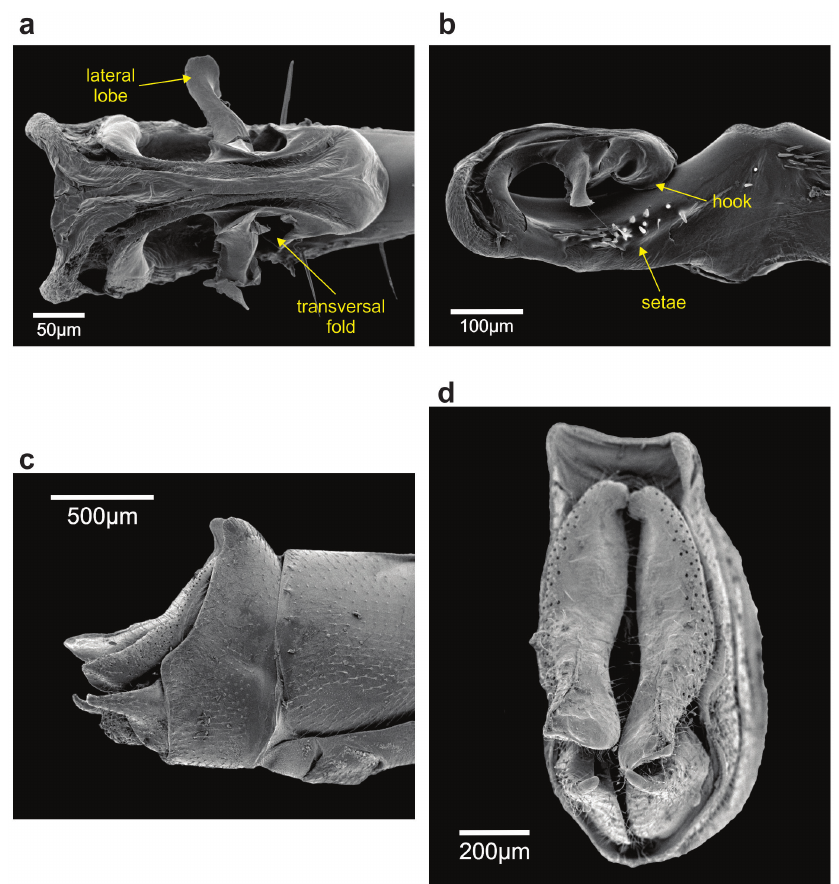
Figure 3 - a . Paratype Brazil, genital ligula ventral view; b . Paratype Brazil, genital ligula lateral view; c . Paratype Brazil, male terminalia lateral view; d . Paratype Brazil, male terminalia posterior